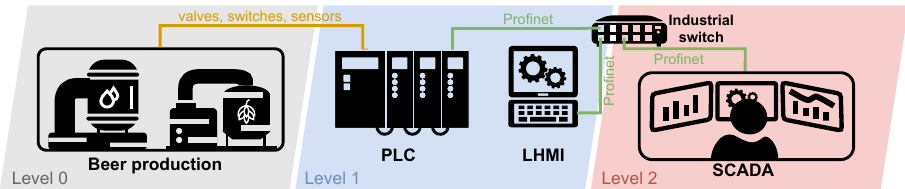
Figure 6. Diagram of physical brewery